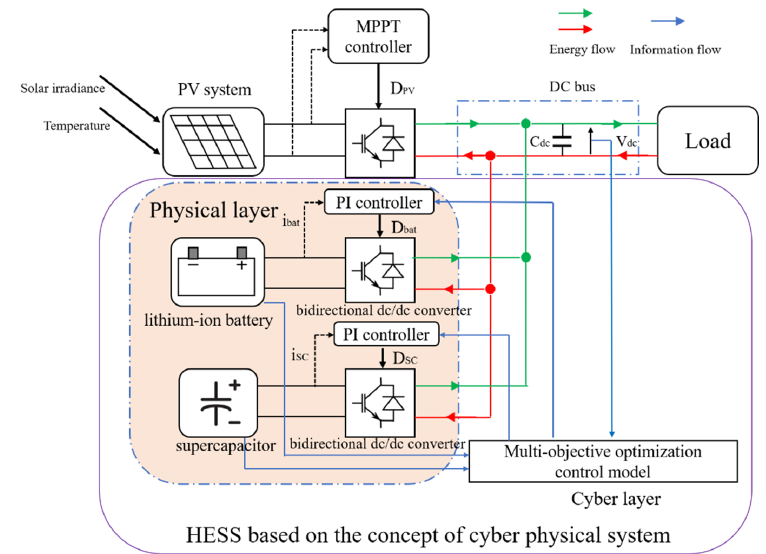
Figure 1. The topology of HESS with PV.